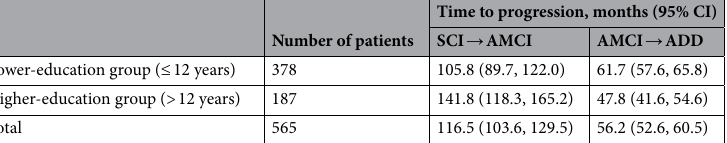
Table 2. Time to transition to disease status according to the level of education. ADD: Alzheimer’s disease dementia; AMCI: amnestic mild cognitive impairment; SCI: subjective cognitive